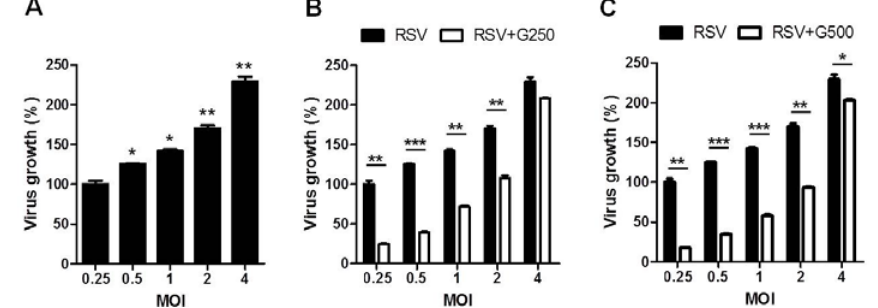
Figure 2. Red ginseng extract (RGE) inhibits respiratory syncytial virus (RSV) replication in human epithelial cells. ( A ) Growth of RSV in human epithelial cell line HEp2 cells. Values are the mean ± SEM. * p < 0.05; ** p < 0.01 vs. RSV-infected control at a MOI of 0.25; ( B , C ) Effects of different RGE concentrations on the growth of RSV in HEp2 cells infected with RSV at different MOIs 48 h post infection. Values are presented as mean ± SEM